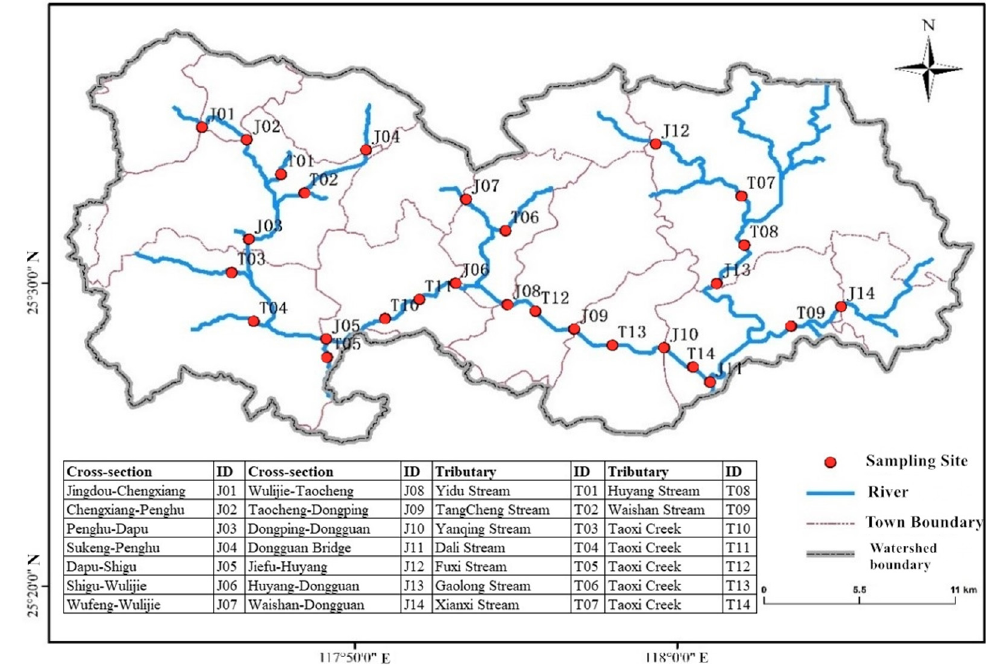
Figure 2. Sampling sites in the Taoxi Creek watershed.